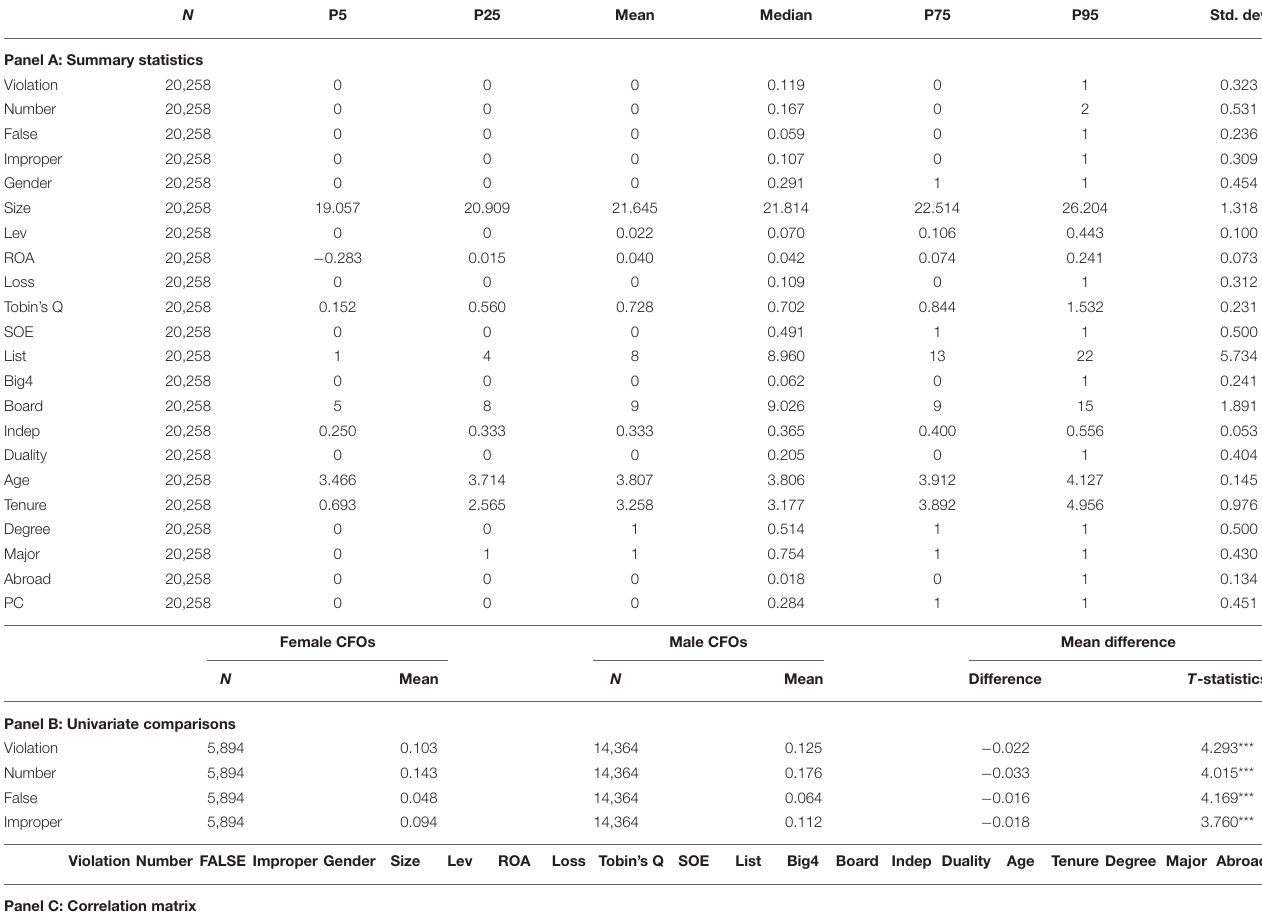
TABLE 1 | Summary statistics and univariate comparisons.